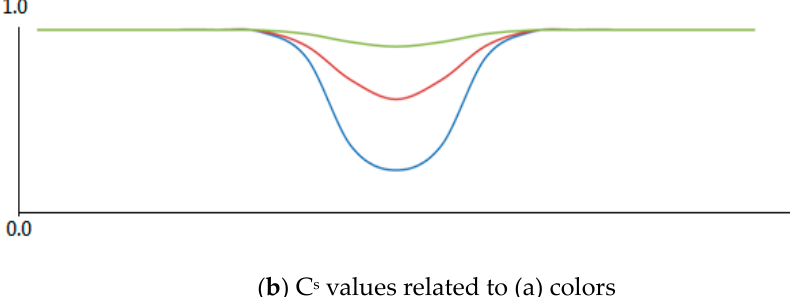
Figure 1. C s values simulated for the different slopes of a roof and derived from the tensor voting method (TVM).